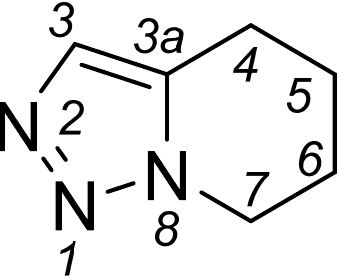
Figure 1. Structure and atom numbering of 4,5,6,7-tetrahydro-[1,2,3]triazolo[1,5-a]pyridine core .